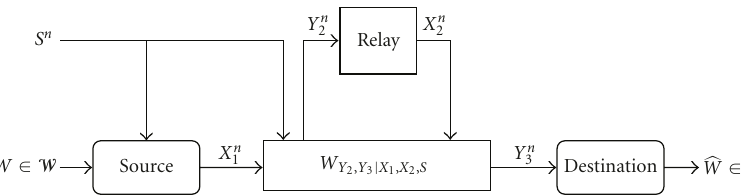
Figure 1: Relay channel with state information S n available noncausally at only the